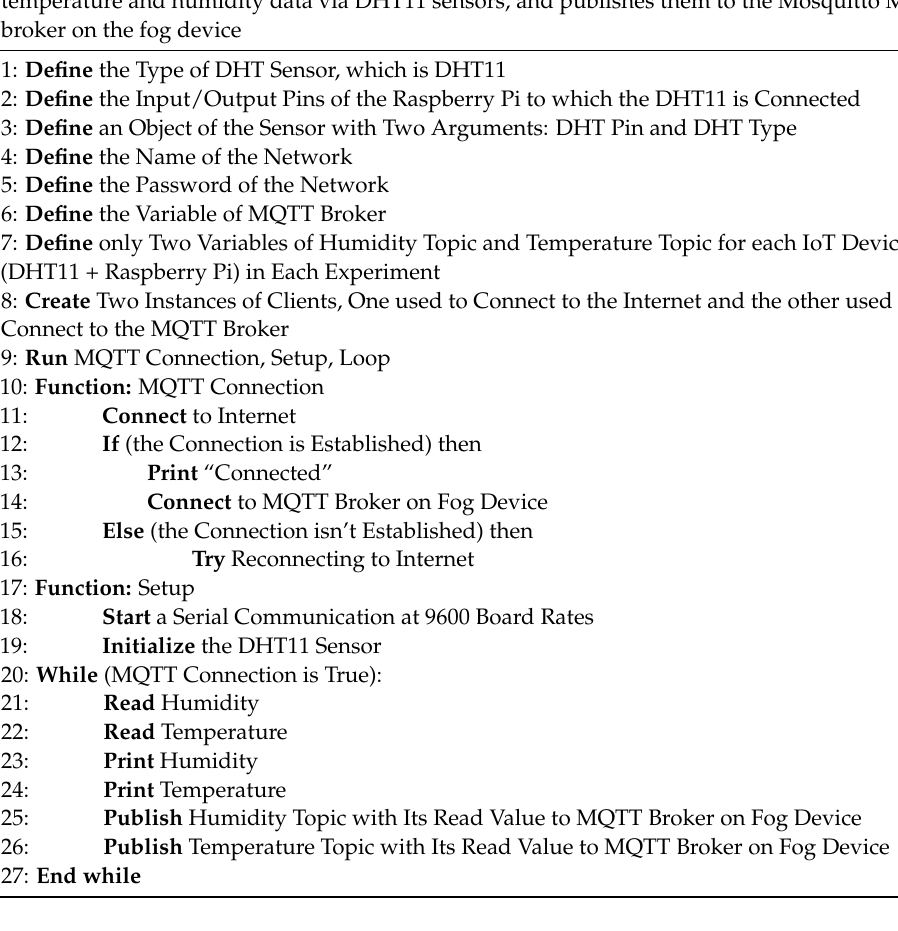
Algorithm 2. Bridge every message received from the IoT devices based on the topics of the messages to the AWS broker on the cloud/*. This algorithm authenticates the IoT device to the MQTT broker on the fog device, bridges to the data received from the sensors via the